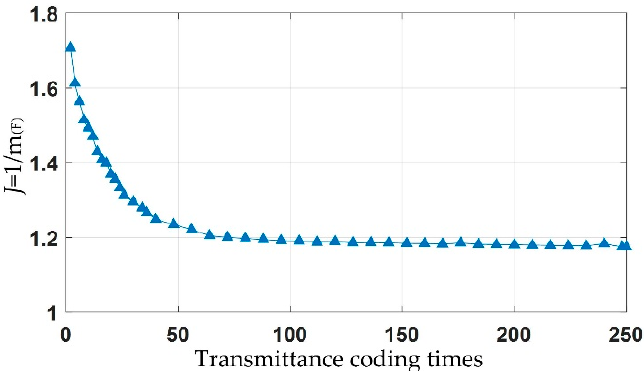
Figure 5. Relationship between the characteristic criterion and the number of transmittance coding.